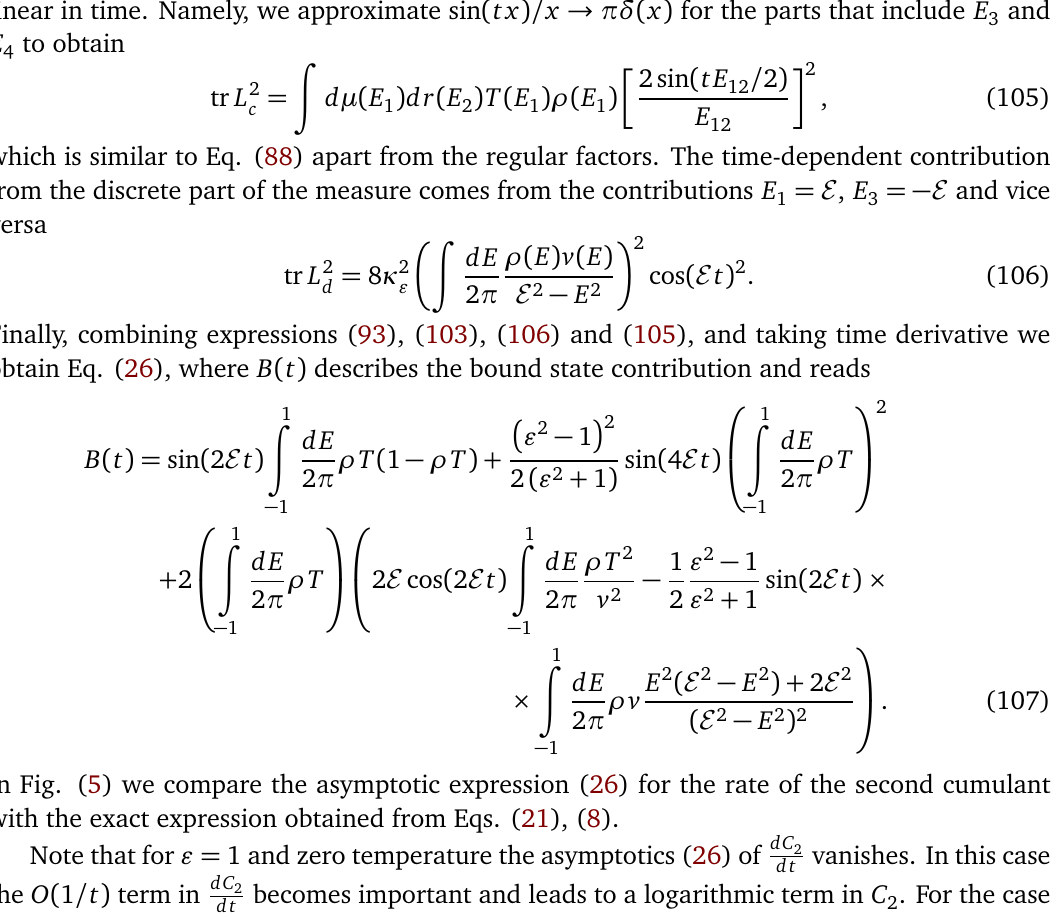
of the second cumulant of the particle number in the right Figure 5: The rate dC 2 dt chain for (cid:34) = 2.4 and zero temperature initial state. The left panel corresponds to the fully filled initial state, Φ = π , and the right one to the half-filled initial state, Φ = π/ 2. The blue curve corresponds the exact expression deduced from Eqs. (21), (8), while the red one is given by the large-time asymptotic expression